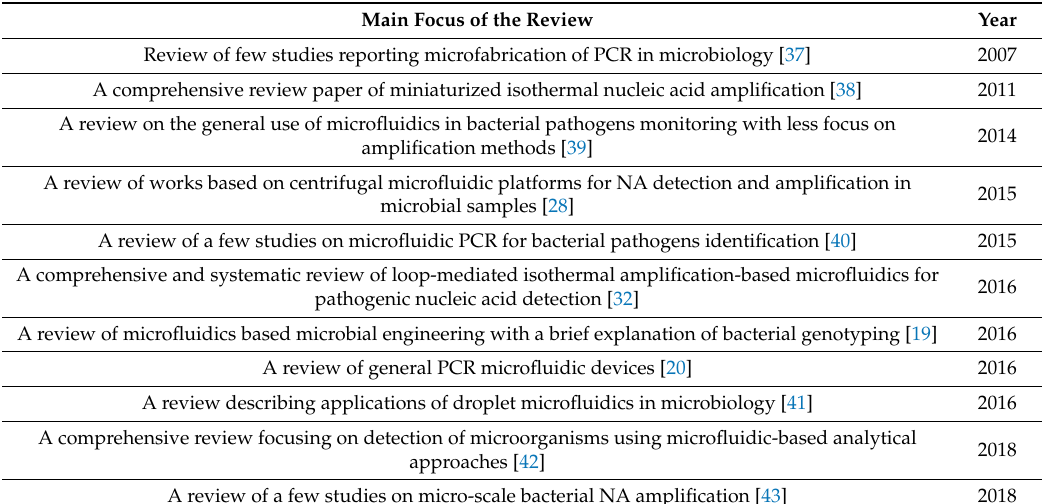
Table 1. Summary of previous review articles addressing the microfluidic-based bacterial nucleic acid (NA) amplification approaches in chronological